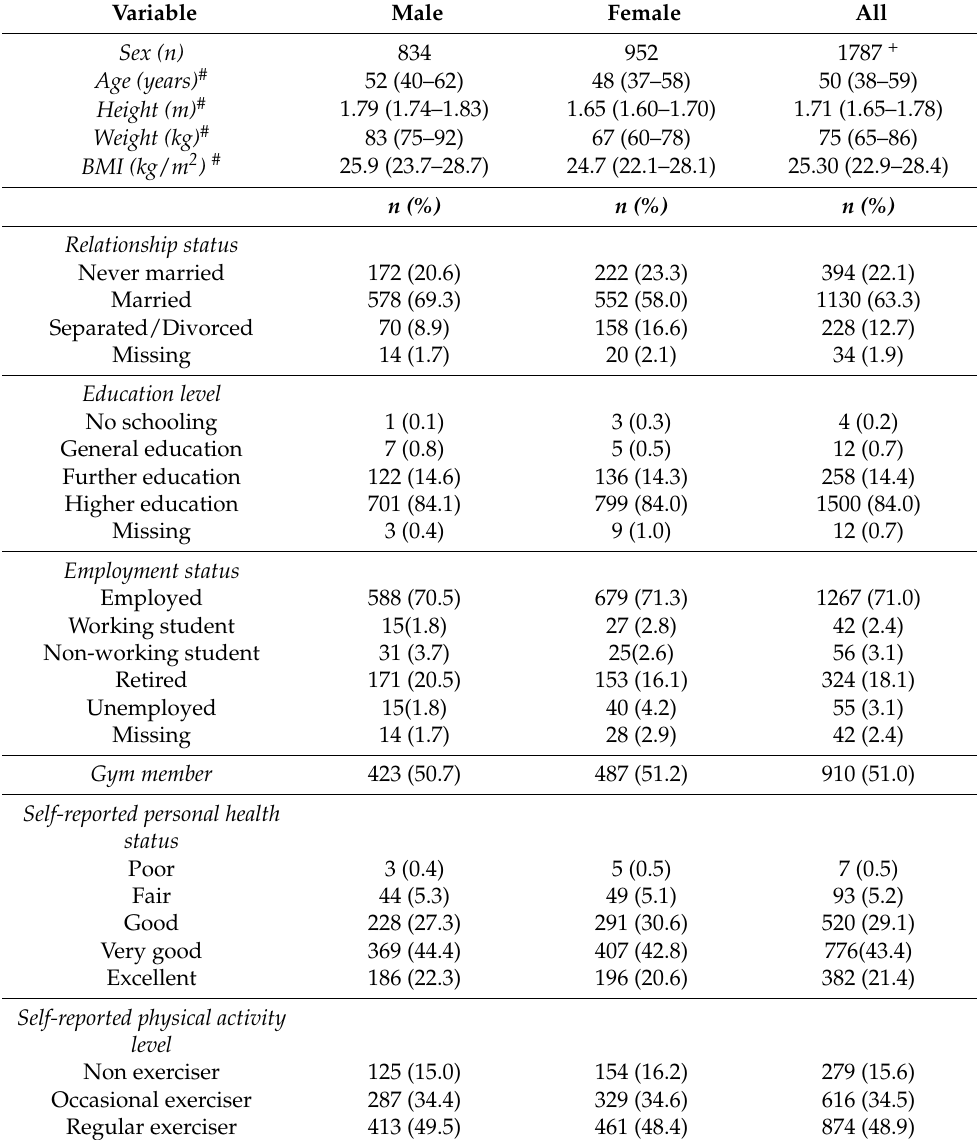
Table 1. Demographic characteristics of the sample.